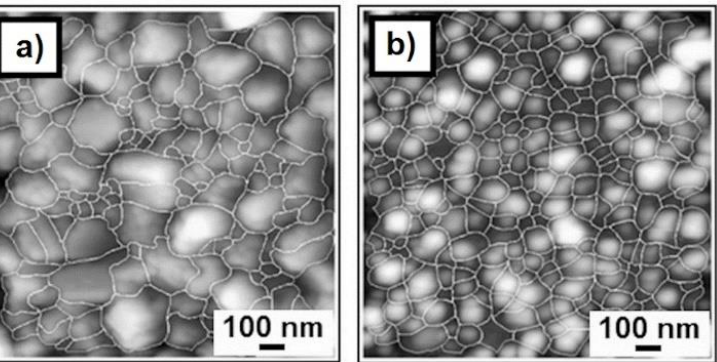
Figure A1. Grain boundary outline: ( a ) aluminum film and ( b ) Al-4B film. The AFM images correspond to films sputtered at 100 W.